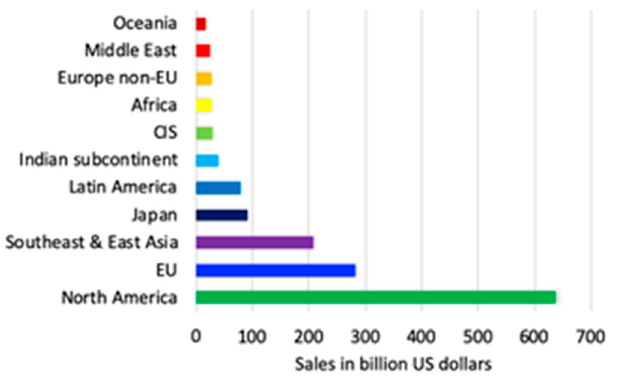
Figure 2. Projected global pharmaceutical sales for 2022 by region [83].